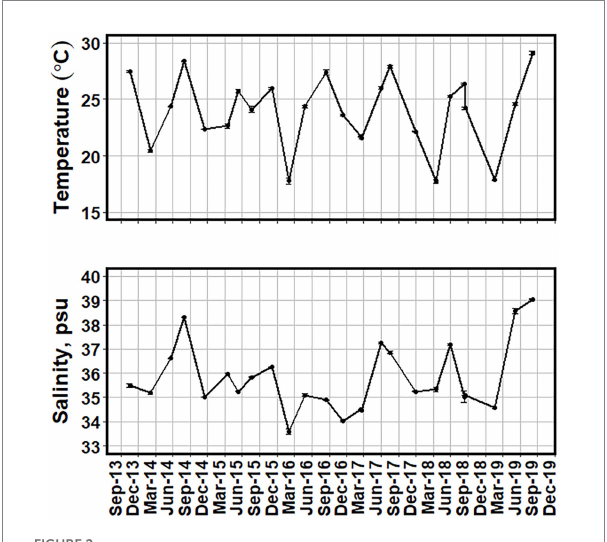
FIGURE 2 Mean surface water temperature ( ° C) and salinity (psu) from all sites between October 2013 and August 2019. Error bars of one standard error are added to show the variance of the values.